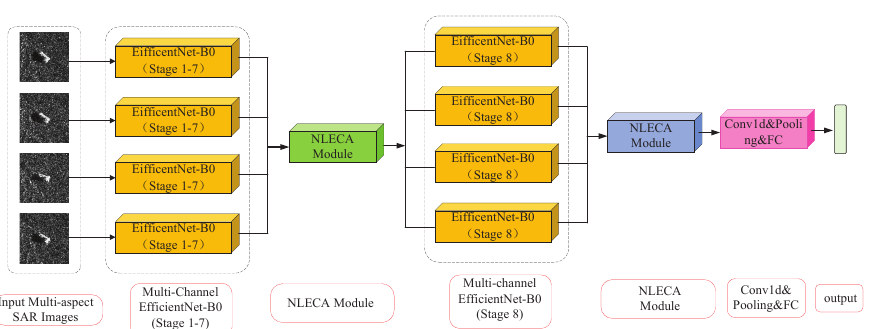
Figure 7. Multi-channel EfficientNet-B0 embedded with NLECA module.